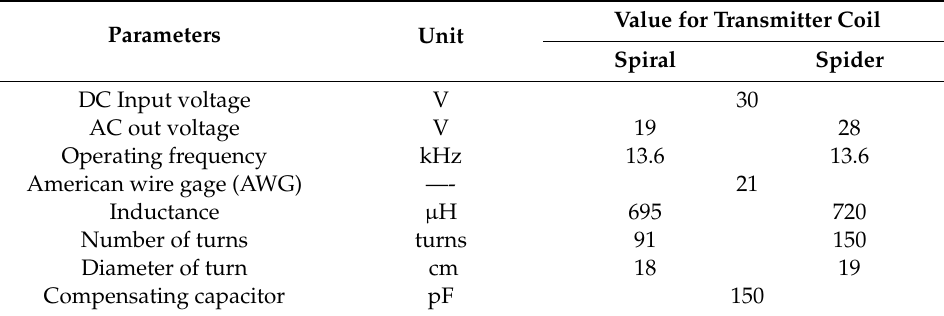
Table 1. Specification for transmitter coils.